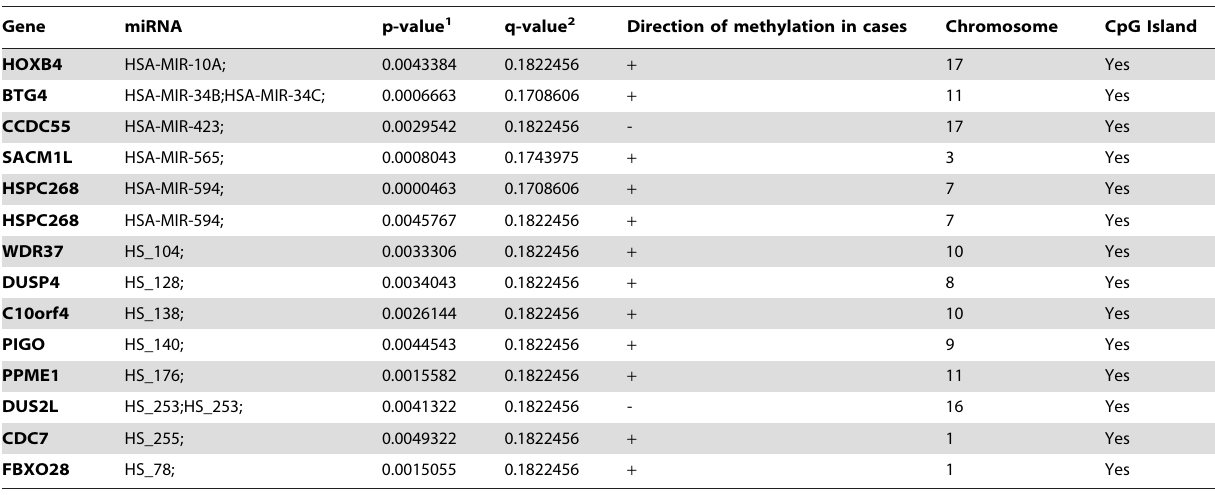
Table 4. Differentially methylated